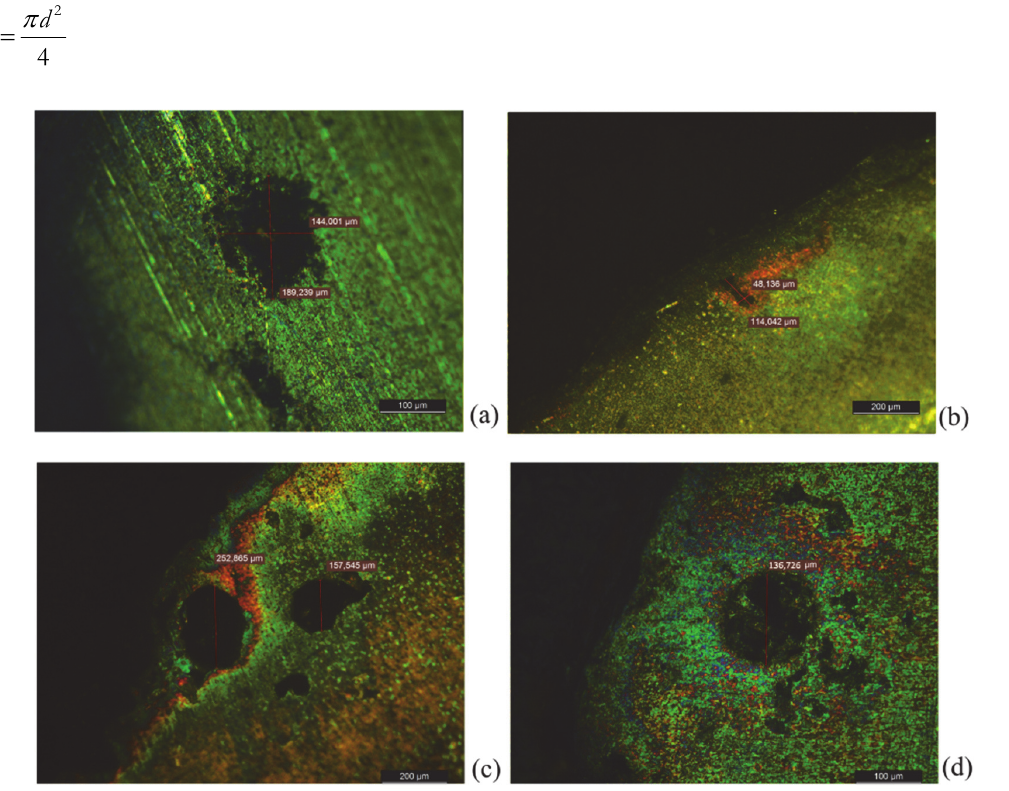
Figure 8: Corrosion damage: Diameter of a pit at a transverse cross-section of non-blasted specimen (a), of sandblasted specimen (b) after 30 days of corrosion as well as of non-blasted specimen (c), of sandblasted specimen (d) after 60 days of corrosion.